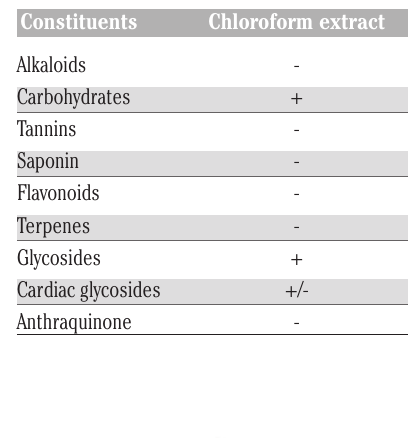
Table 1. Phytochemical screening of chlo- roform extract of Punica granatum L.